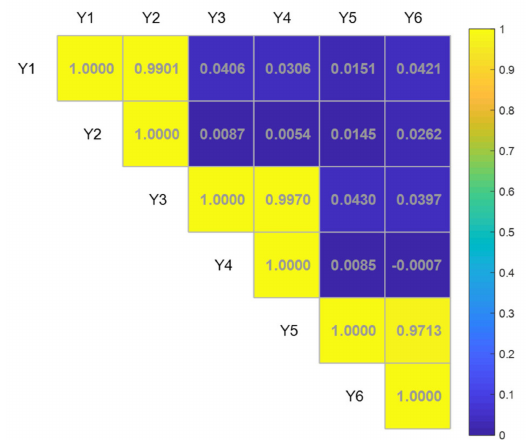
Figure 5. Matrix graph of cosine